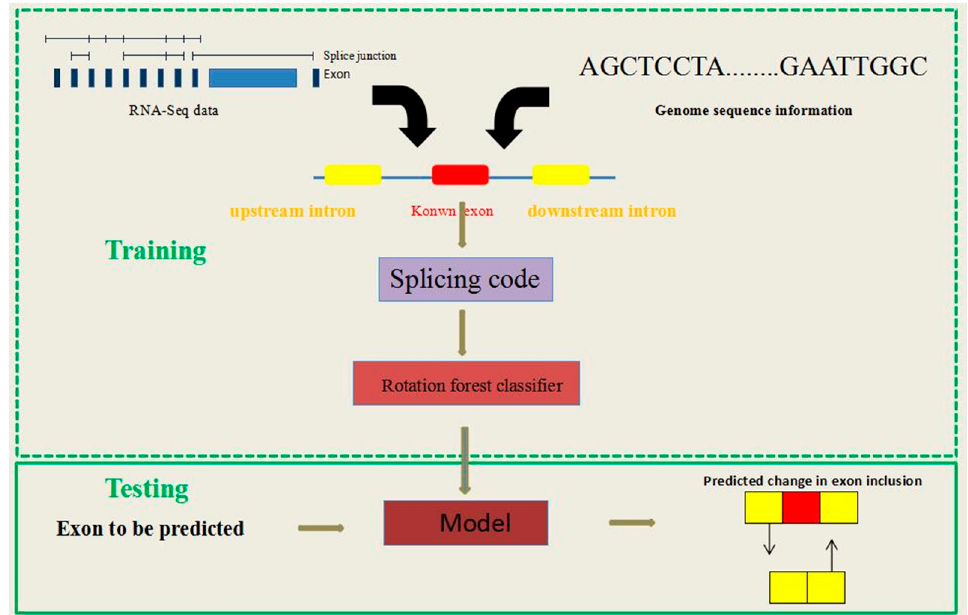
Figure 1. The framework of Rotation Forest classifier to predict ES events with RS features (RotaF-RSES), showing both the training and testing stages. RotaF-RSES involves two steps. Step 1: Obtaining known exons, their upstream and downstream introns, and then extract RNA-Seq features and sequence features according to their RNA-Seq data and sequence information. The above two features, called RS features, were used to build a classification model based on a Rotating Forest algorithm (RotaF-RSES). Step 2: After obtaining the RS features of an unknown type of exon, the RotaF-RSES model was used to determine the type of exon.